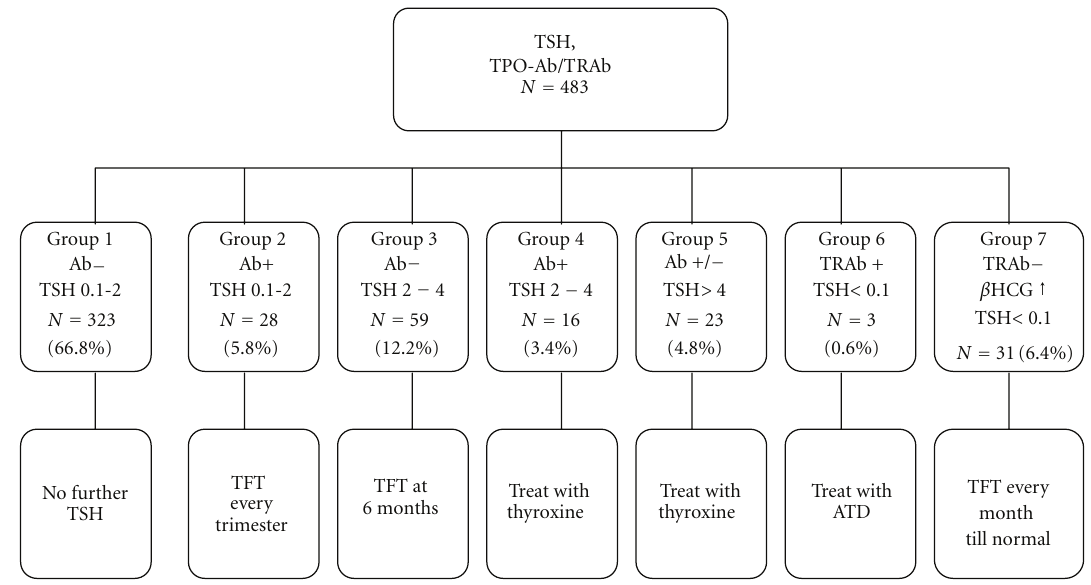
Figure 1: Classification into various groups based on TSH and antibody status. TSH: Thyroid stimulating hormone in μ IU/mL, TPOAb: thyroid peroxidase antibody. TRAb: TSH receptor antibody, hCG: human chorionic gonadotropin. TFT: thyroid function tests (FT3, FT4, TSH, and TPO titres in those with positive TPOAb). ATD: antithyroid